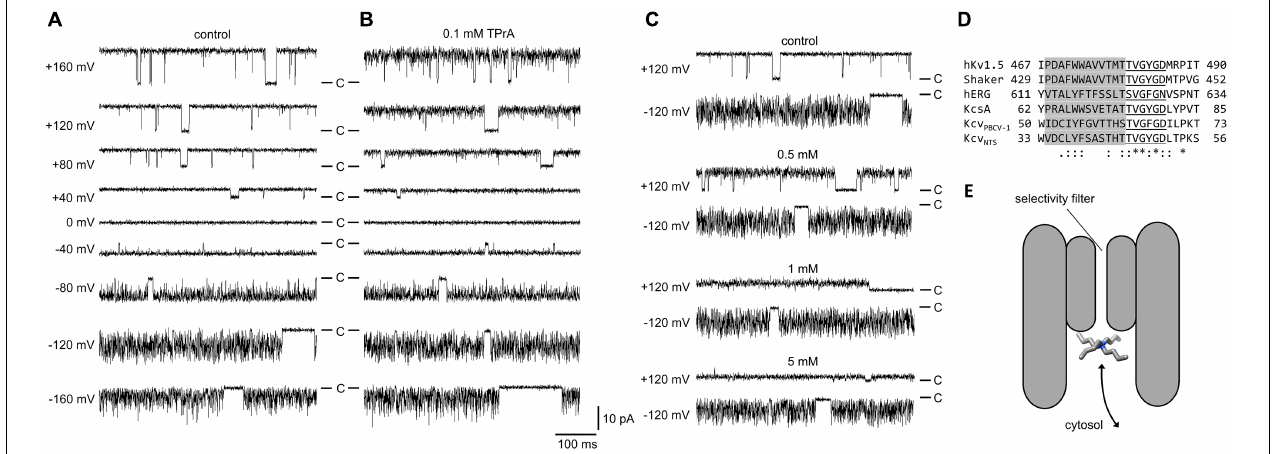
FIGURE 1 | Block of single-channel currents in Kcv NTS in DPhPC membranes by cytosolic TPrA. (A,B) Representative time series measured in symmetrical 100 mM KCl at different membrane voltages between +160 mV and − 160 mV (A) without TPrA and (B) with 0.1 mM TPrA. (C) Time series measured in different concentrations of TPrA at +120 and − 120 mV. The scale bar refers to all three panels in this figure. C marks the closed state. The data for ± 120 mV without TPrA are displayed in both (A,C) . (D) Alignment of the pore loop of two viral K + channels (Kcv NTS , Rauh et al., 2017b), the one used in this study, and Kcv PBCV − 1 (Tayefeh et al., 2009), a bacterial K + channel (KcsA, UniProtKB/Swiss-Prot: P0A334.1) and three eukaryotic potassium channels ( Shaker , GenBank: CAA29917.1, hERG, GenBank: BAA37096.1, and human Kv1.5, NCBI Reference Sequence: NP_002225.2). Sequence conservation ( ∗ identity, : conservative,. semi-conservative) was calculated with the Clustal Omega Webapp. The selectivity filter sequence is underlined, the pore helix is shaded in gray. (E) Schematic illustration of the blocking process, the binding site is only accessible from the cytosolic pore